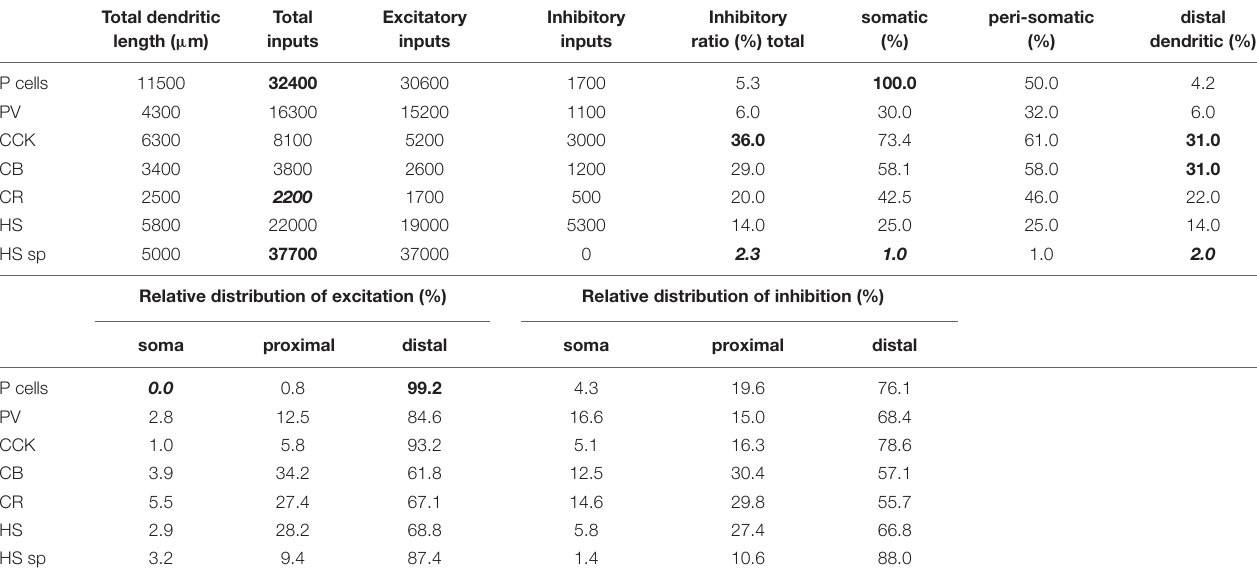
TABLE 1 | Absolute and relative distributions of excitatory and inhibitory synaptic inputs over the surfaces of seven examined hippocampal neuron types. Total dendritic length ( µ